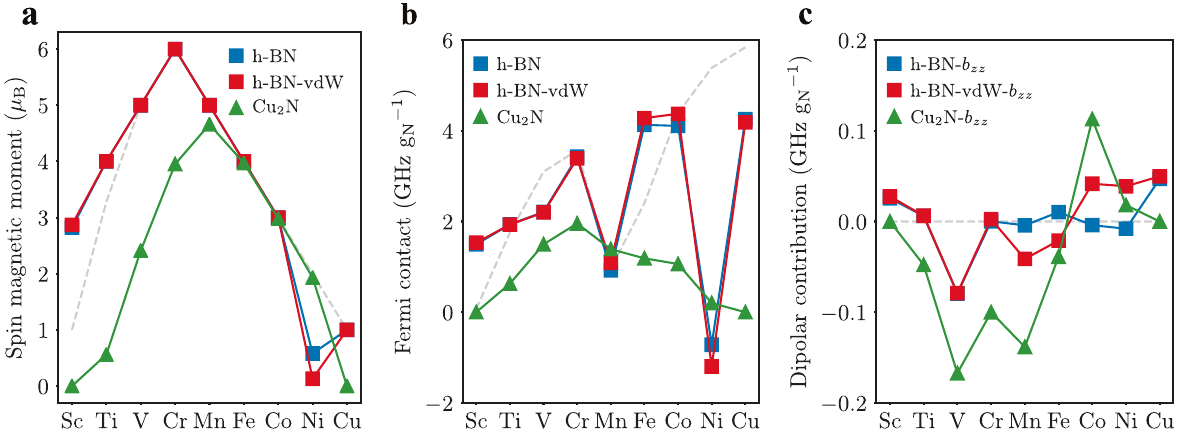
Fig. 7 Magnetic properties of top-stacked adatoms on Cu 2 N and h – BN. a Spin magnetic moment, b Fermi contact and c dipolar contributions to the hyper fi ne interaction. The gray dash line represents the free-atom